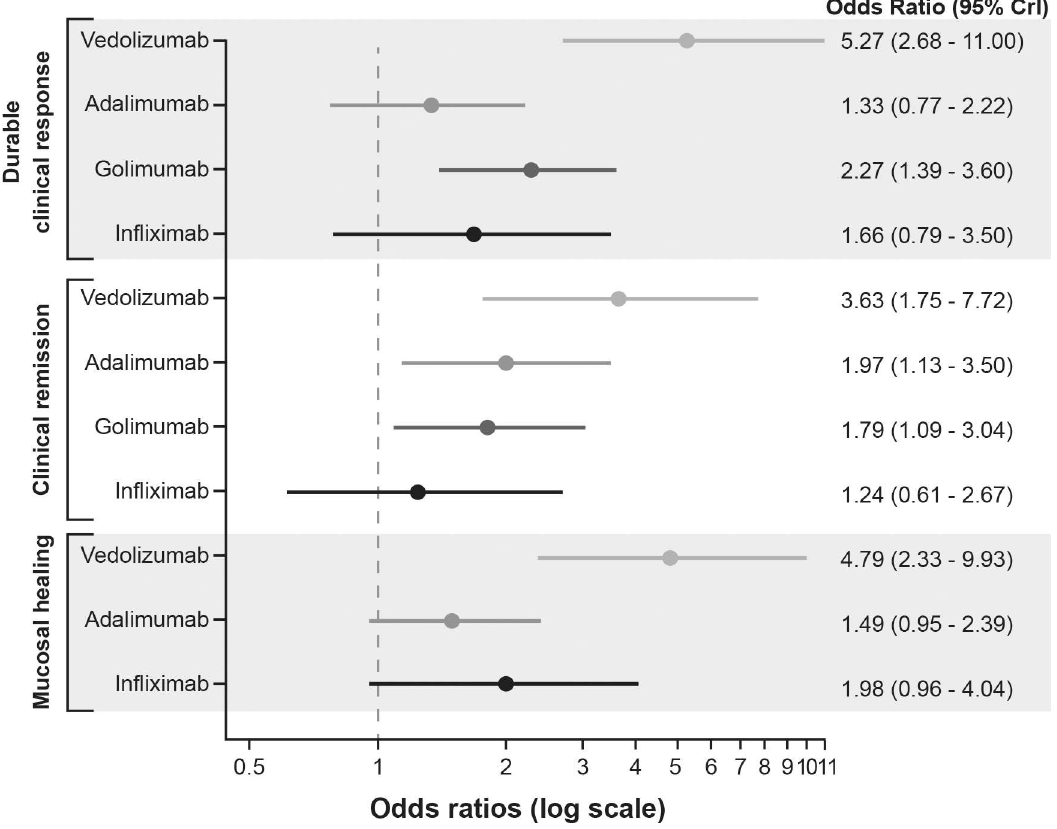
Fig 5. Forest plot of the odds ratios for biologics vs. placebo for anti-TNF therapy-na ï ve patients in maintenance studies. CrI, credible interval; TNF, tumour necrosis factor. Note: Adalimumabmaintenance dose: 40 mg every other week; vedolizumabmaintenance dose: 300 mg every 8 weeks; golimumab maintenance dose: 100 mg every 4 weeks; infliximabmaintenance dose: 5 mg/kg intravenously every 8